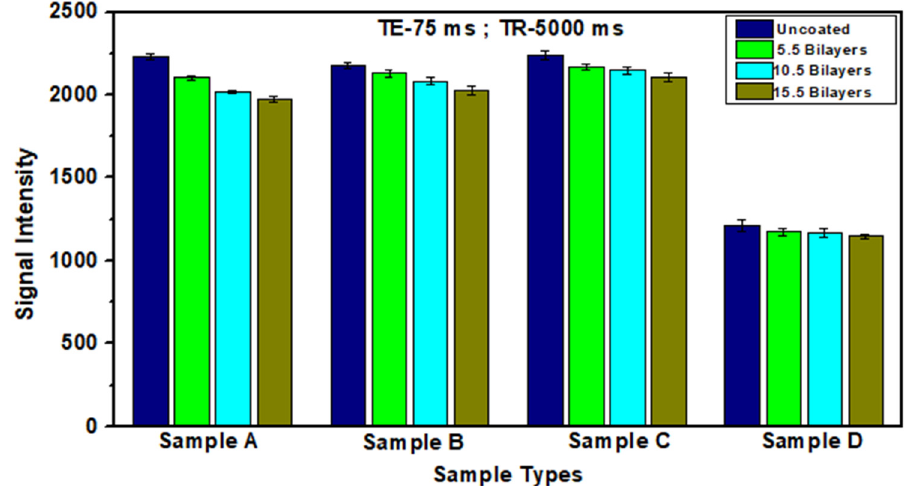
Figure 15. Mean signal intensity graph of thin film gradients of samples A, B, C and D fabricated at various pH combinations for TE 75 ms and TR = 5000 ms.